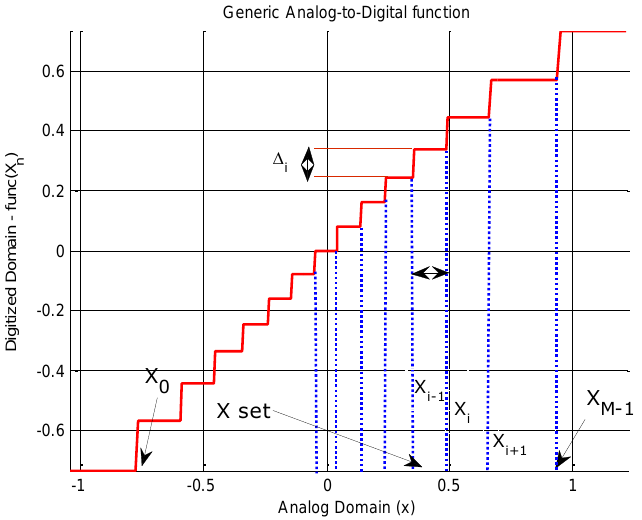
Figure 1. Generic analog-to-digital transfer function. The function plotted has compression gain and different steps in analog and digitized